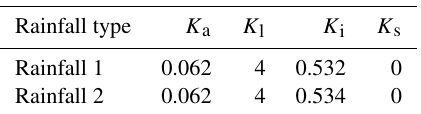
Table 2. The parameters of the theoretical equation for the labora- tory